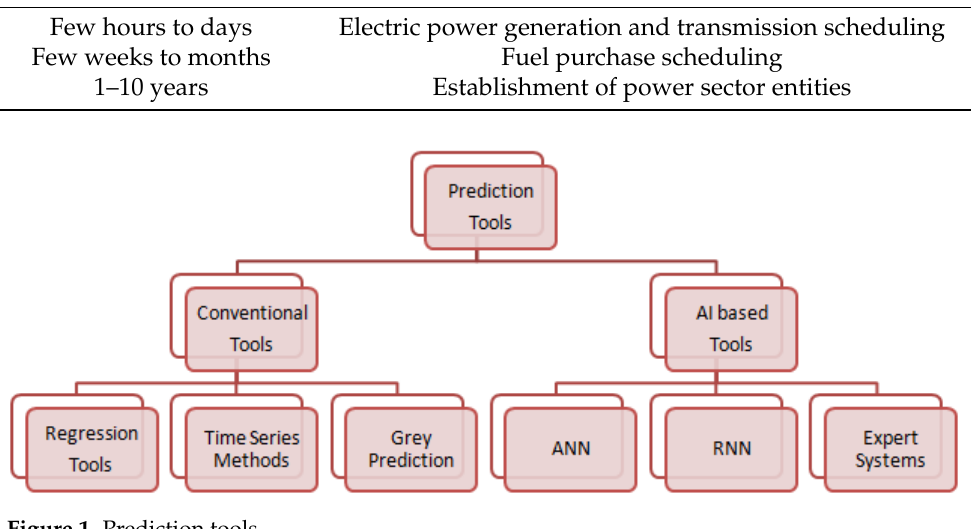
Figure 1. Prediction